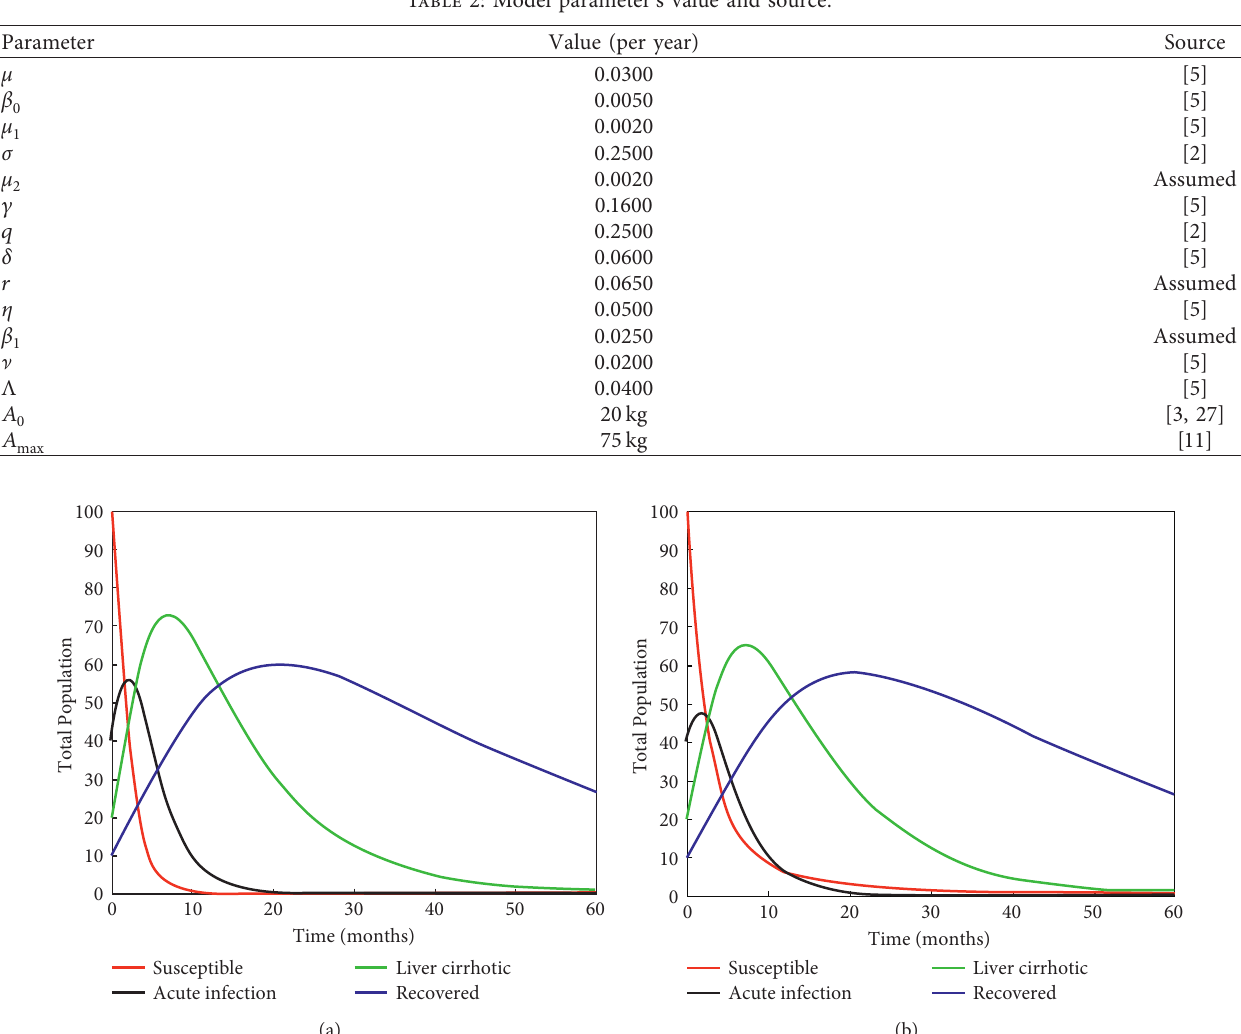
Figure 4: The plots demonstrate the simulation results of all trajectories S ( t ) ,I ( t ) , C ( t ) , R ( t ) converging to disease free-equilibrium (a) when the amount of alcohol consumed is A ( t ) � A